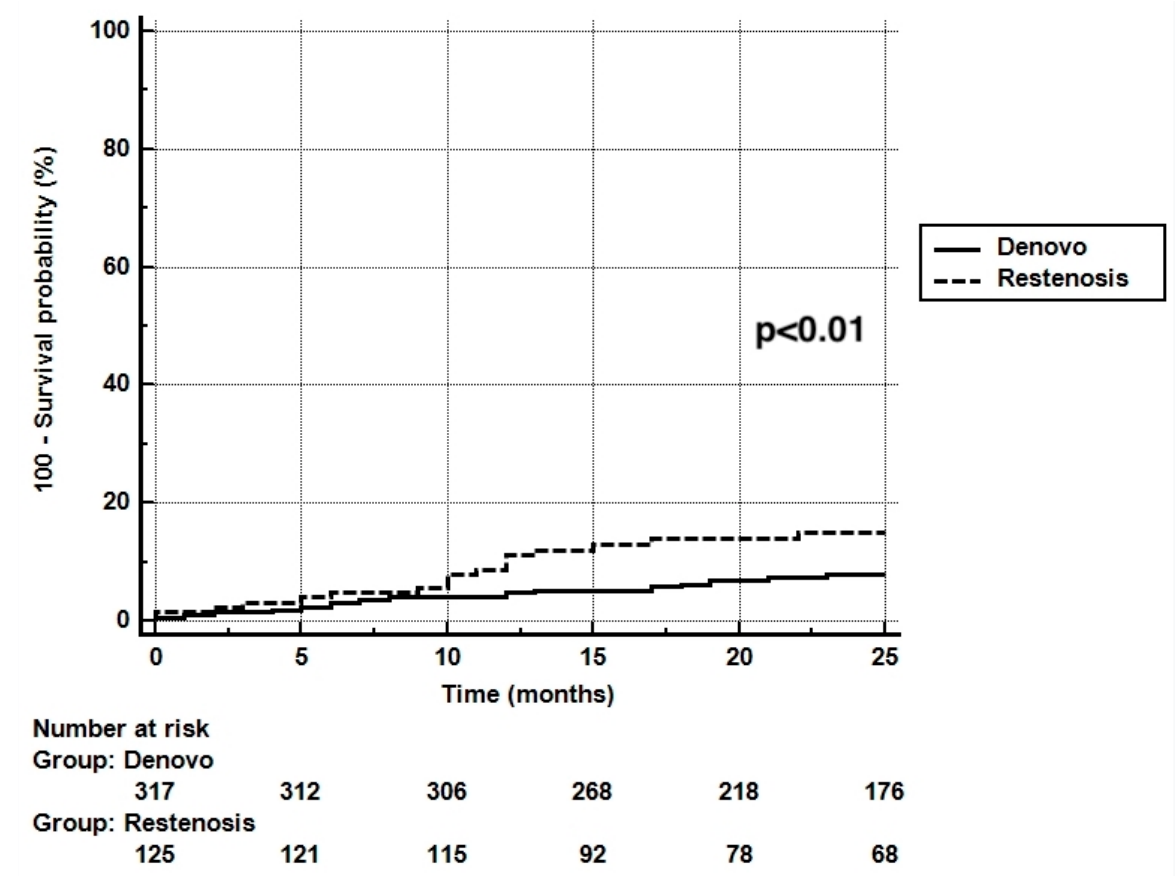
Figure 2. KM in-stent restenosis vs. de novo lesions.